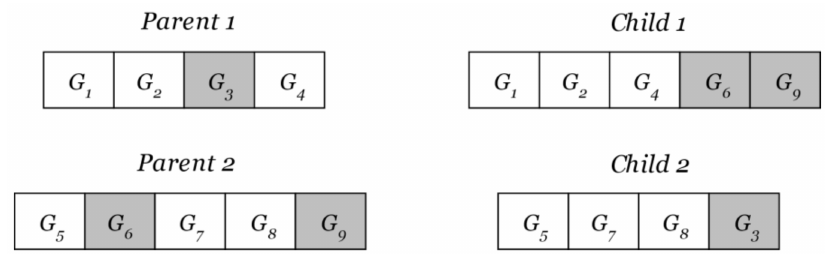
Figure 2. High-level crossover